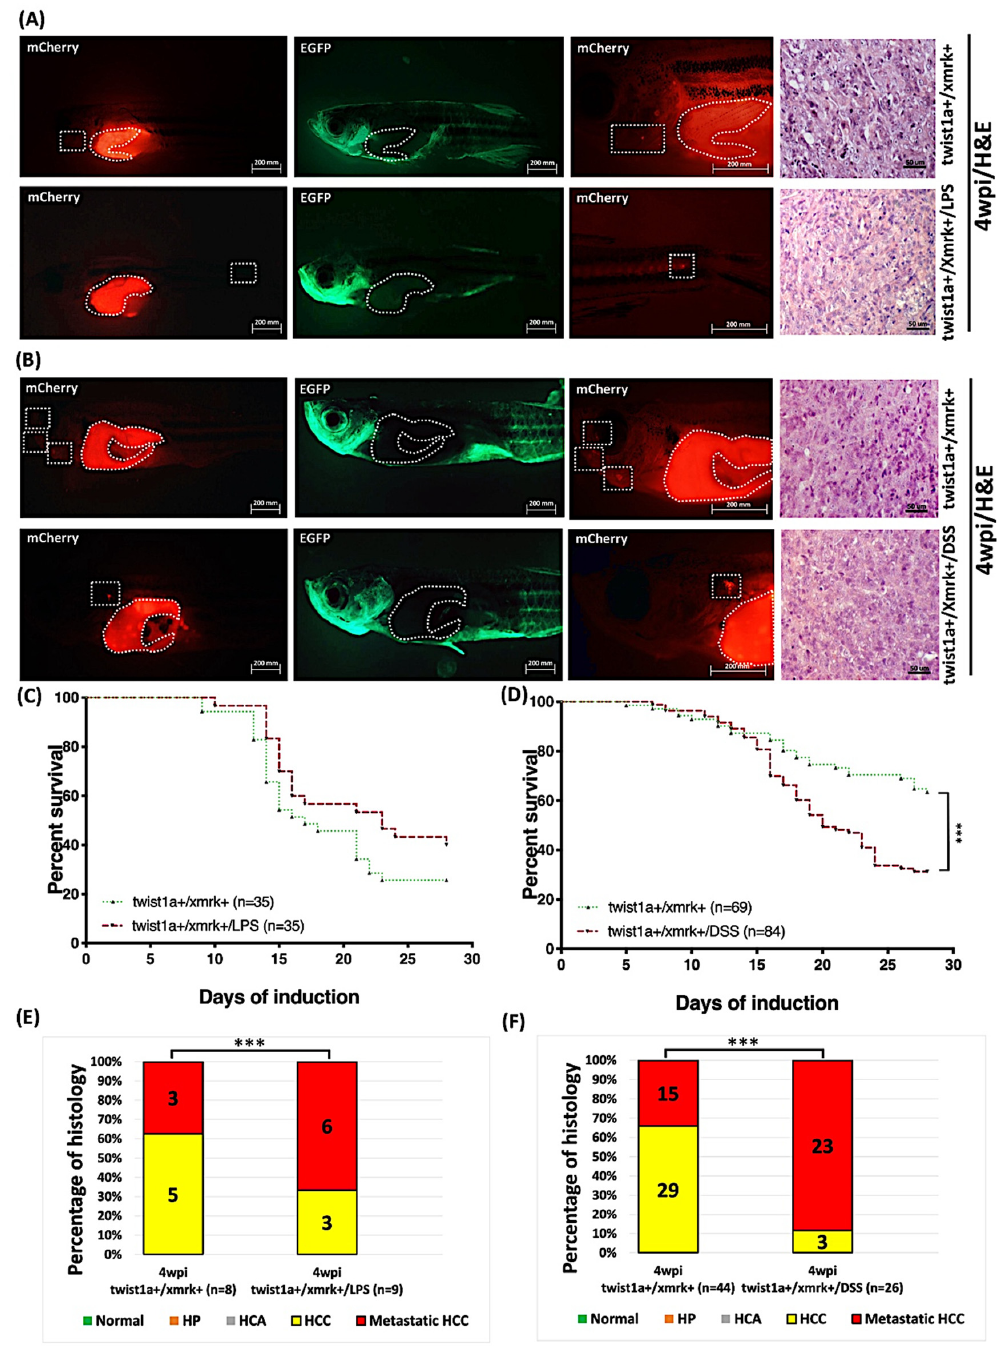
Figure 8. Induction of tumor metastasis in twist1a+ / xmrk+ transgenic zebrafish via Dox and 4-OHT treatment under exposure to LPS or DSS. Twist1a+ / xmrk+ transgenic zebrafish were treated with 60 μ g/mL Dox and 1 μ g/mL 4-OHT starting from 4 mpf with sampling performed at 4 wpi. ( A , B ) Immunofluorescence analysis of twist1a +/ xmrk + liver tumor metastasis at 4 wpi with corresponding H&E histological examination of liver sections. Scale bar: 50 or 200 μ m. ( C , D ) Kaplan–Meier survival curves showing days post-induction plotted against percentage survival to 4 wpi. ( E , F ) Histological examination confirmed that at 4 wpi, all twist1a+ / xmrk+ transgenic zebrafish developed HCC or metastatic HCC. Differences among the variables were assessed using one-way ANOVA. Statistical significance: *** p < 0.001.